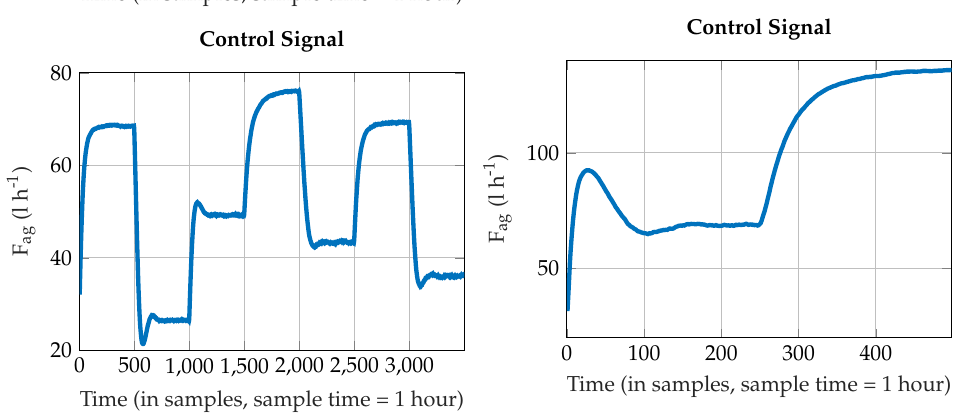
Figure 13. Closed loop performance of the Yeast Fermentation Reaction Temperature Control system.